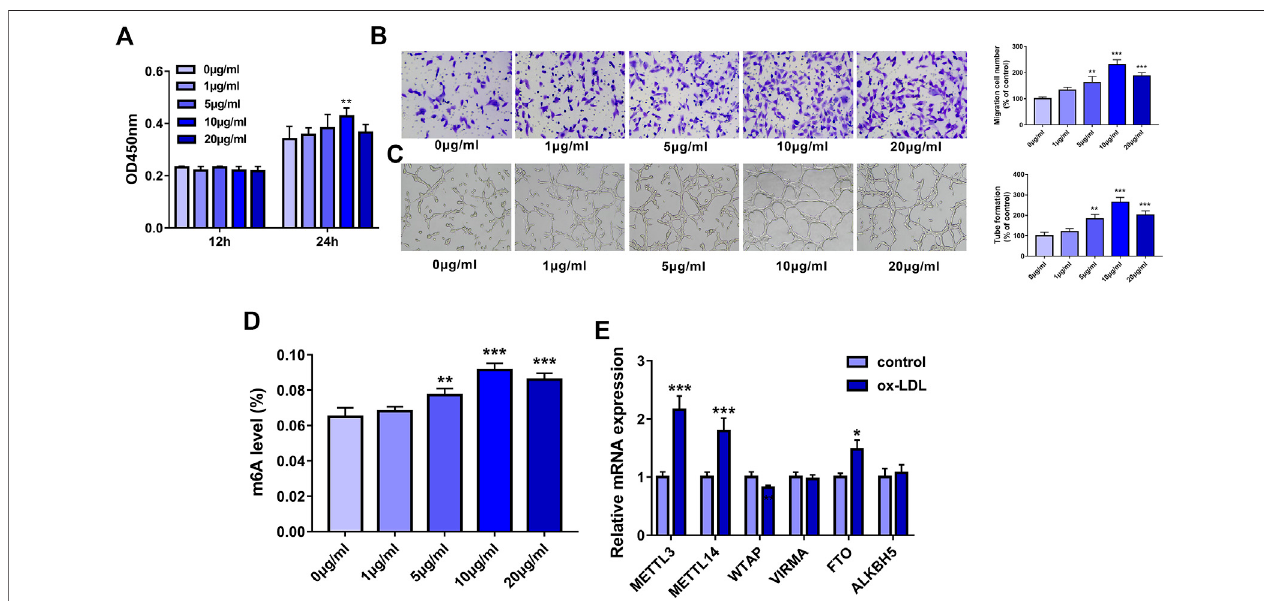
FIGURE1| METTL3washighly expressed inox-LDL-treated HUVECs. (A – D) HUVECs were treated withdifferentconcentrationsofox-LDL(0, 1, 5,10, or 20 μ g/ ml). (A) Cell proliferative activity was examined through CCK-8 assay at 12 h or 24 h after ox-LDL exposure. (B) Cell migratory ability was analyzed using Transwell migrationassayat24 hafterox-LDLtreatment. (C) Tubeformationcapacitywasassessed bytubeformationassayat12 hafterox-LDLstimulation. (D) Theglobalm6A level in total RNA was measured using a commercial kit at 24 h after ox-LDL stimulation. (E) At 24 h after ox-LDL treatment, mRNA levels of METTL3, METTL14, WTAP,VIRMA,FTO,andALKBH5weremeasuredthroughRT-qPCRassay.Threeindependentexperimentswereperformedforall invitro assays.* p < 0.05,** p < 0.01, *** p < 0.001.